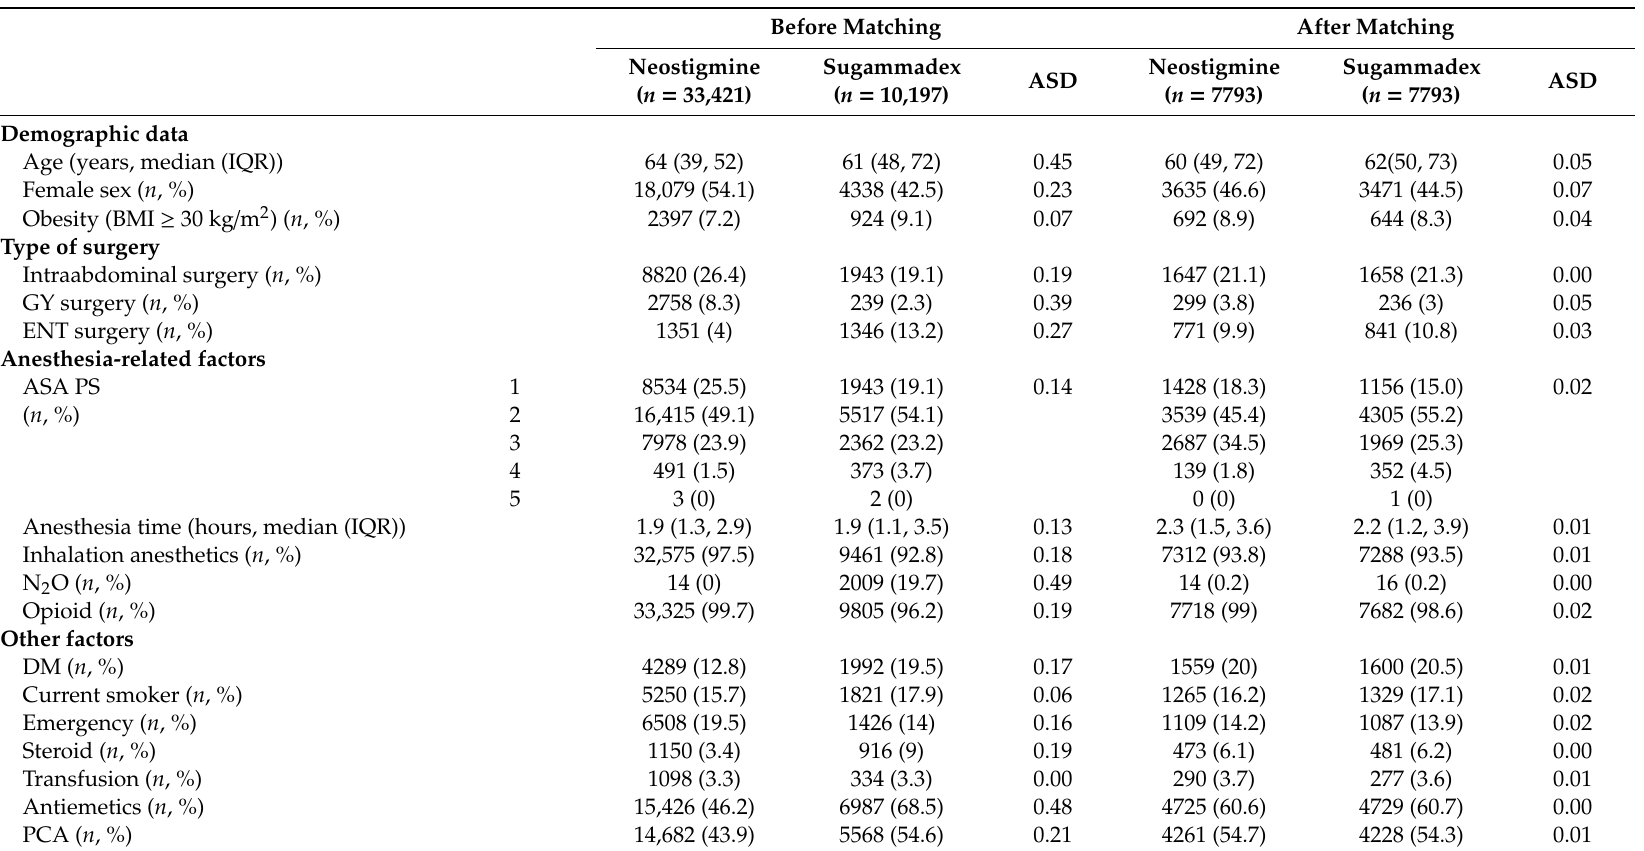
Table 1. Baseline patient characteristics and clinical data before and after matching: comparison between the neostigmine and sugammadex groups. Before Matching After Matching Neostigmine ( n = 33,421)